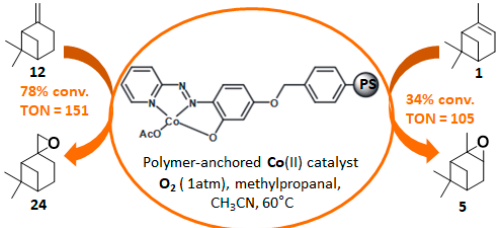
Figure 7. Aerobic oxidation of pinene isomers using a polymer-anchored Co(II) catalyst (adapted from reference [41]).